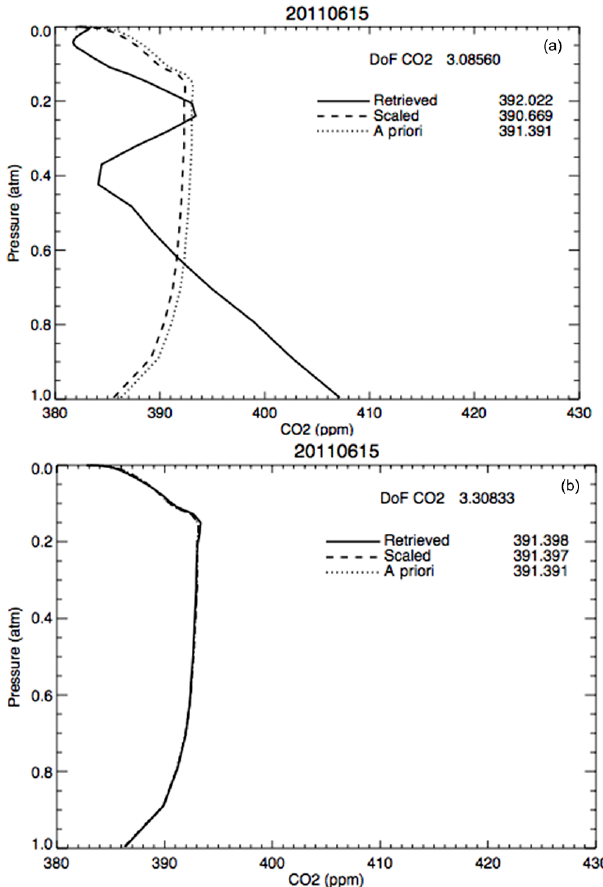
Figure 6. (a) Retrievals with a 1% error in pressure-broadening coefficient assumed. (b) As (a) except the residuals of the scaling retrieval are included in the profile retrieval’s forward